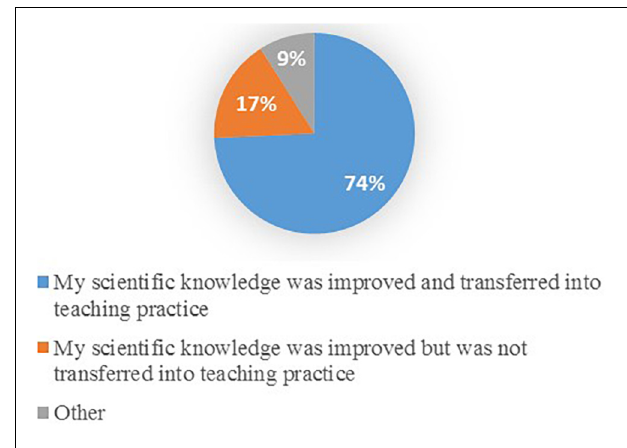
FIGURE 1 | Impact of the seminar on teaching practice.